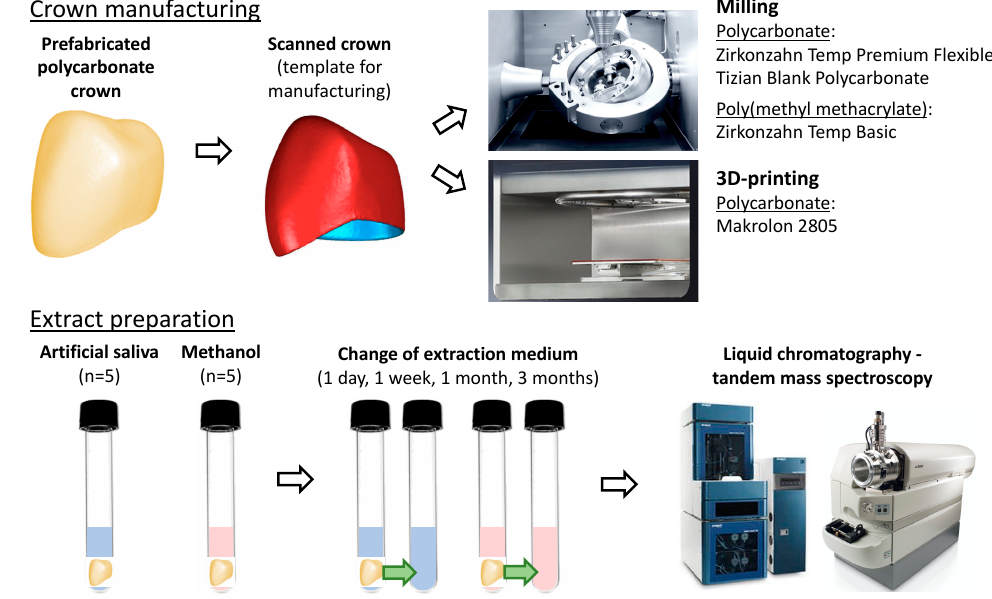
Figure 1. A schematic diagram of the experimental procedures.